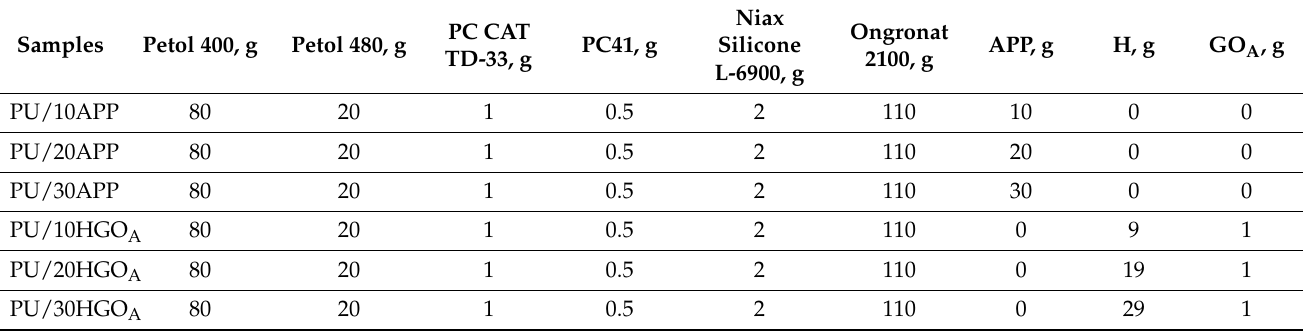
Table 1. Formulations of flame retarded PU.